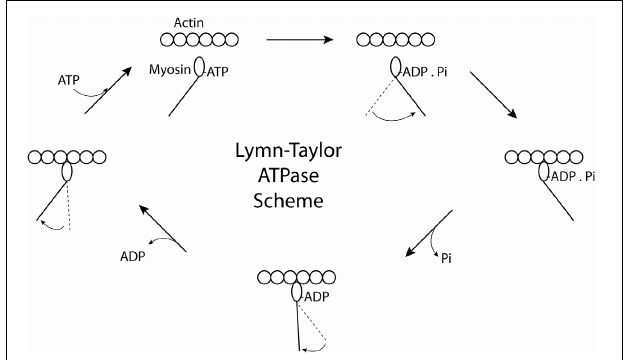
FIGURE 2 | Cartoon of the Lymn-Taylor Scheme. The scheme illustrates how the chemical energy obtained from hydrolyzing ATP is converted into mechanical